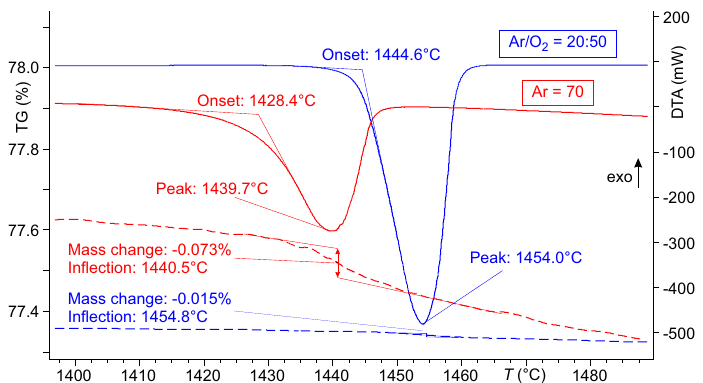
Figure 2. DTA (full lines) and TG (dashed lines) of CaO–Fe 2 O 3 mixtures with 70% CaO. Sample masses were 65–70mg, atmosphere was Ar (99.999% purity) or an Ar/O 2 mixture (flow rates given in mL/min.)